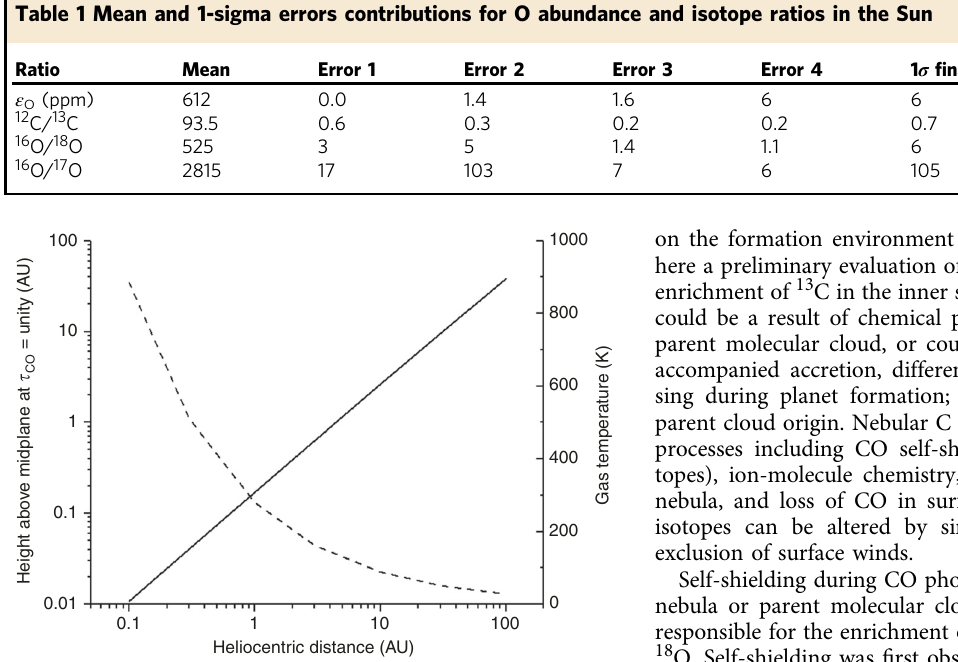
Fig. 6 Height above midplane at which τ CO = unity. Calculation assumes a CO absorption cross sections σ CO = 1 × 10 − 16 cm 2 and a CO fraction (relative to H 2 ) f CO = 2 × 10 − 4 (i.e., a H 2 column density of 10 20 cm − 2 ). The corresponding H 2 number densities vary from ~10 10 cm − 3 at 0.1 AU to ~10 6 cm − 3 at 100 AU. Vertically isothermal gas temperature is also shown (dashed line). Calculations use an analytical disk model chemical composition and the isotopic ratios in the photosphere are expected to be very close to the convective zone for heavier elements like oxygen and carbon. Downward convective over- shoot into the radiative zone reduces gravitational settling effects. If convective overshoot into the radiative zone is neglected, the depletions in convective zone and photospheric δ 13 C, δ 15 N, and δ 18 O are − 6.1, − 4.4, and − 9.1 ‰ , respectively 28 . With convective overshoot present, the depletions in convective zone δ 13 C, δ 15 N, and δ 18 O are predicted to be − 4.3, − 3.1, and − 6.4 ‰ , respectively 28 . These predicted isotopic shifts are non-negligible, and are mass-dependent, but fall within the 1 σ uncertainties of the photospheric O and C isotope results presented here. For this reason we have not shown isotopic shifts due to gravitational settling explicitly in either Figs 4 or 5.